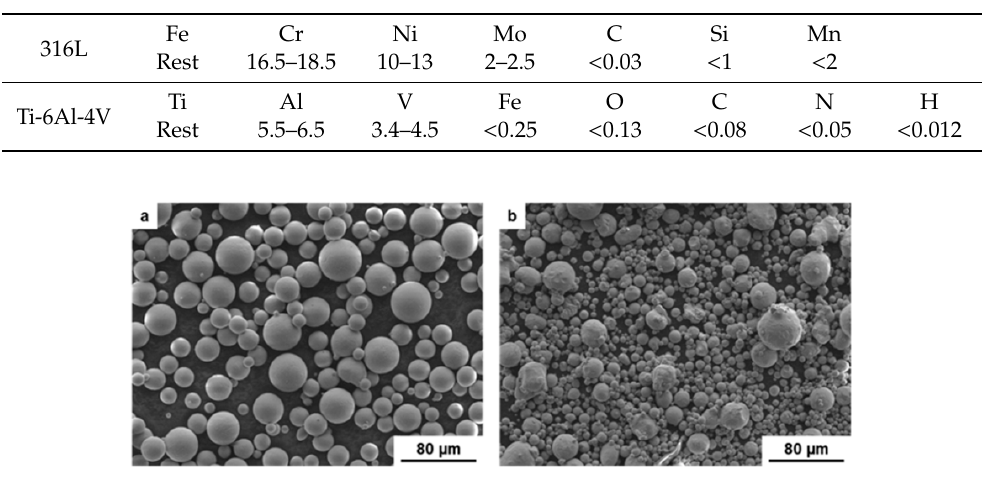
Figure 2. SEM micrographs of powders, ( a ) Ti6Al4V; ( b ) 316L [35].